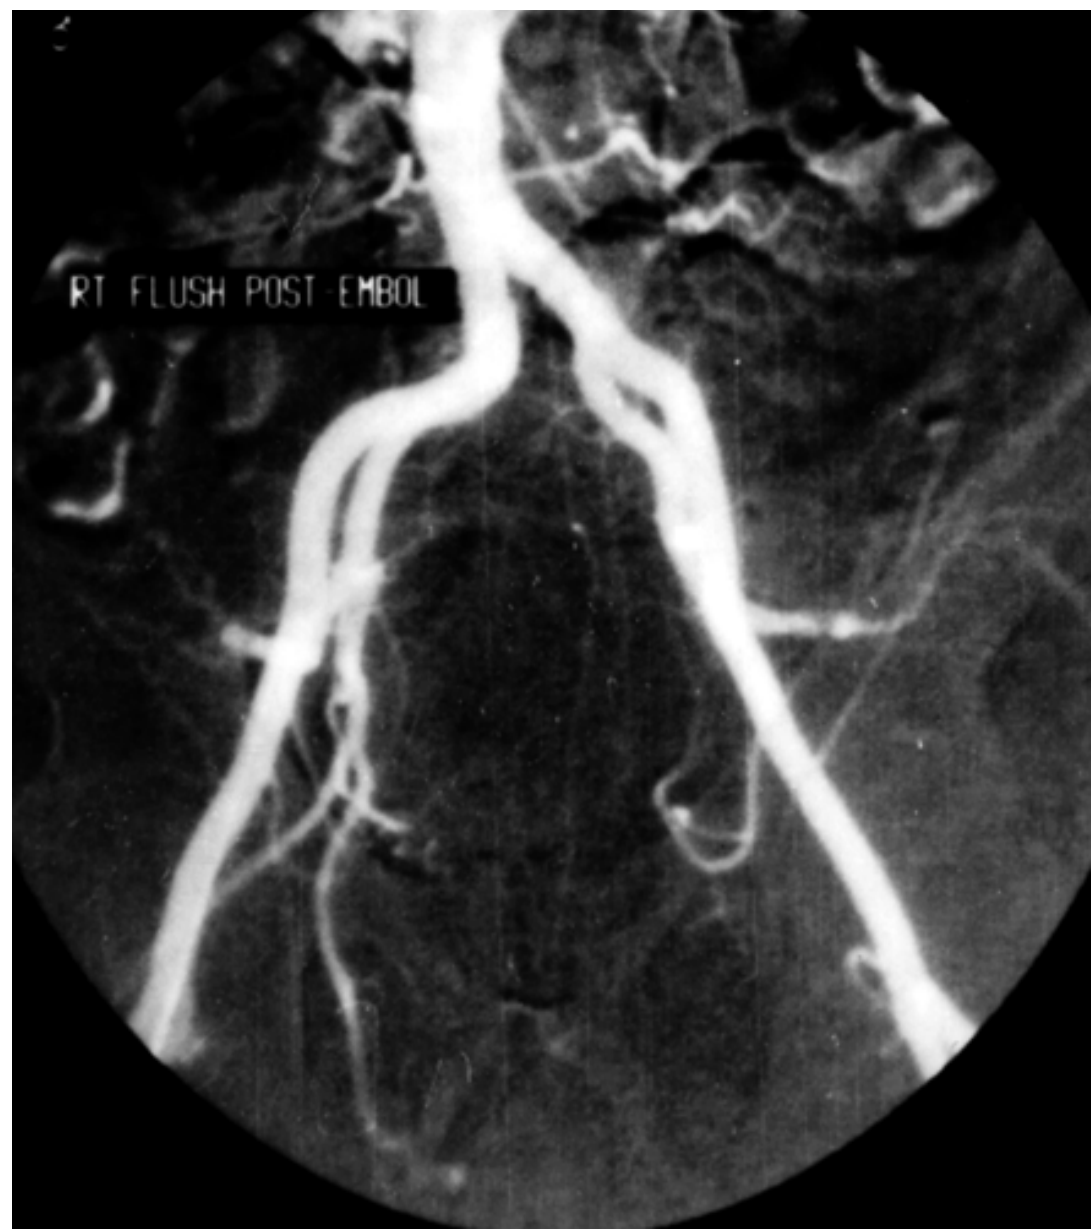
FIGURE 3. Postembolization subtraction arteriogram showing complete obliteration of blood flow to the bladder wall